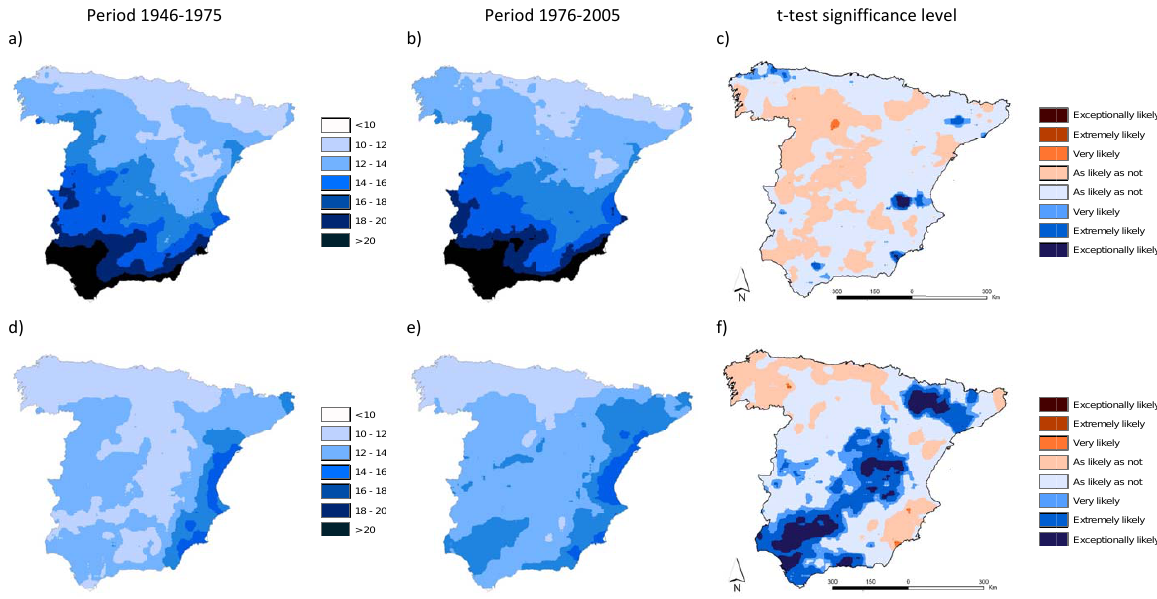
Fig. 3. Mean value of the Precipitation Concentration Index (wet-dry periods) during the periods 1945–1975 and 1976–2005 and changes between periods according to different levels of probability categorized as follow: exceptionally likely ( p < 0 . 01); extremely likely ( p < 0 . 05); very likely ( p < 0 . 10); as likely as not ( p > 0 . 10). (a) , (b) , (c) dry season; (d) , (e) , (f) wet season. Blue positive, red negative